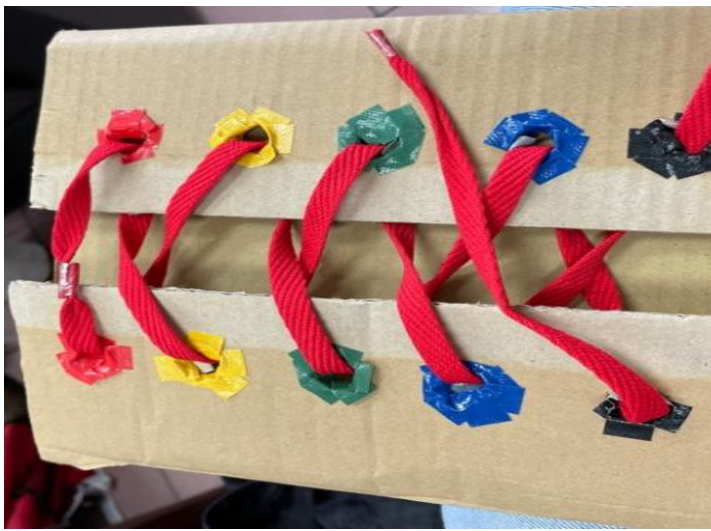
Figure 1. Educational materials made by a teacher (from the Taichung Special Education School for the Visually Impaired) for teaching students how to tie